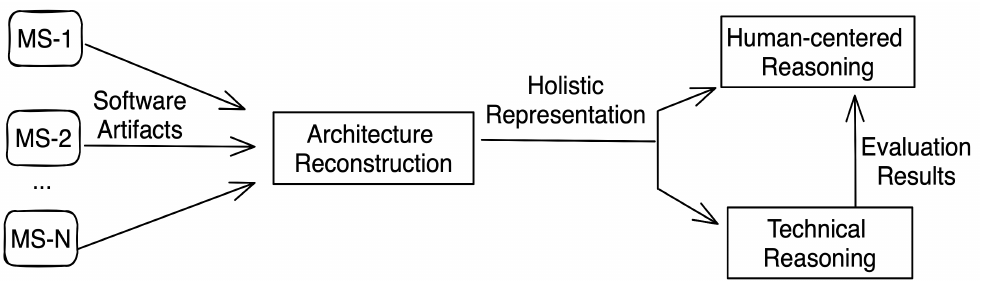
Figure 1. Microservices reasoning process